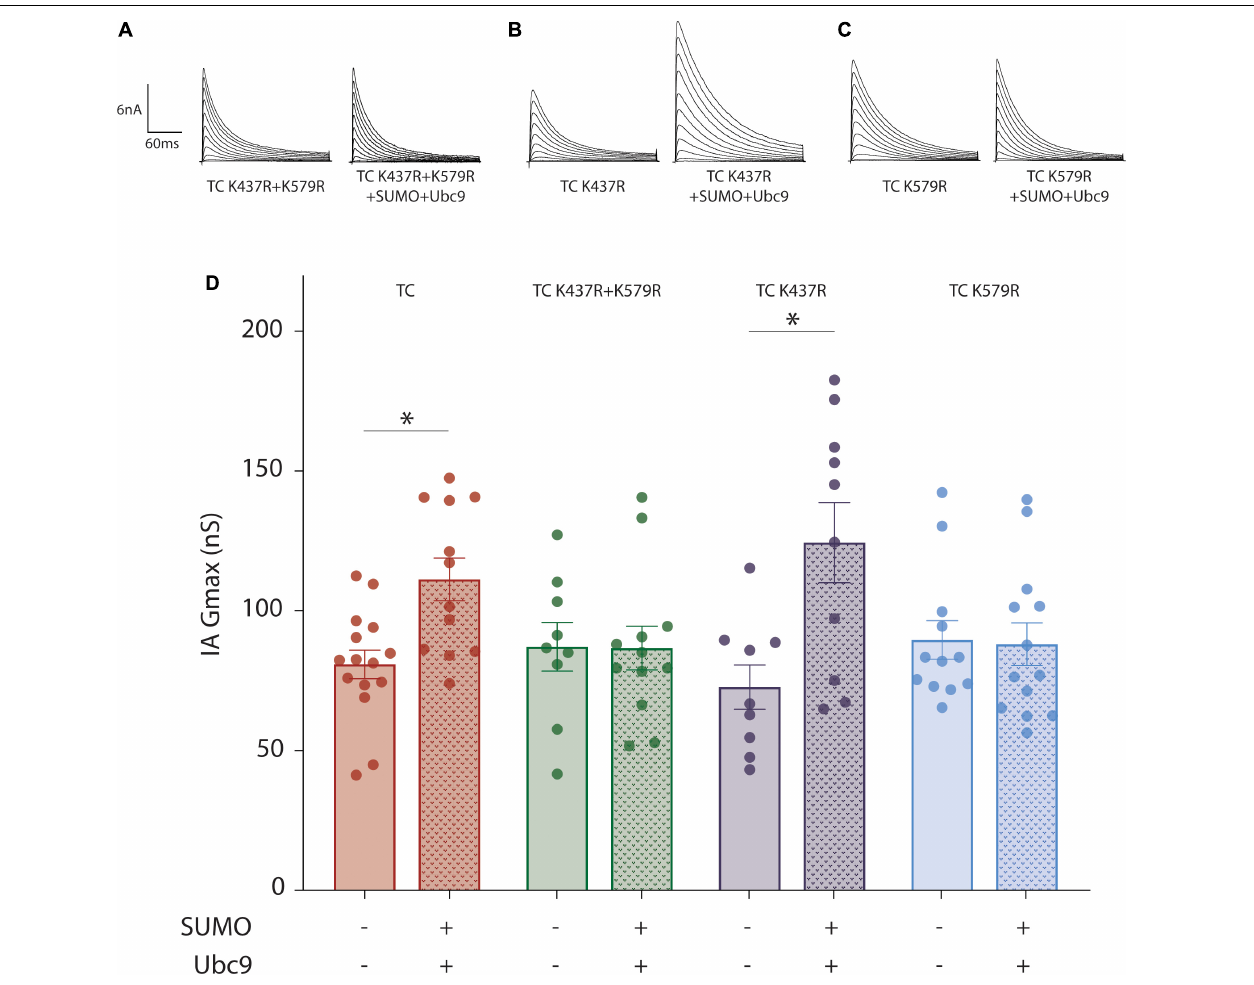
FIGURE 3 | SUMOylation of Kv4.2g at K579 increases IA Gmax mediated by the TC. A mutant Kv4.2 plasmid, K437R + K579R or K437R or K579R, was co-expressed with wild type HA-KChIP2a and HA-DPP10c in HEK cells to generate mutant TCs. (A–C) Representative current traces for mutant TCs when SUMOylation was or was not increased by co-transfecting SUMO2 + Ubc9. (D) Bar graph showing the mean ± SEM IA Gmax for each treatment group. Note that wild-type data are replotted from Figure 1 for the sake of comparison. Each dot represents one cell collected from ≥ 3 transfections. Asterisk, significant differences. TC K437R + K579R: control, 87.11 ± 8.7 nS vs. SUMO2 + Ubc9, 86.7 ± 7.8 nS, t -test p = 0.97; TC K437R: control, 72.7 ± 7.9 nS vs. SUMO2 + Ubc9, 124.4 ± 14.3 nS, t -test p = 0.007; TC K579R: control, 89.6 ± 6.9 nS vs. SUMO2 + Ubc9, 88.0 ± 7.6 nS, Mann–Whitney U p =